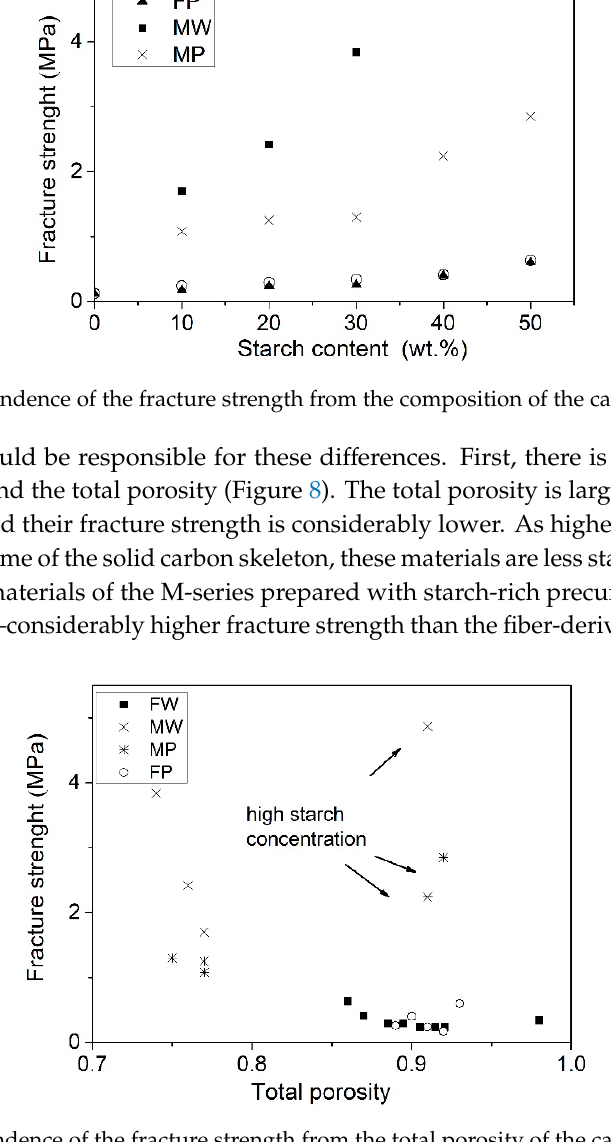
Figure 8. Dependence of the fracture strength from the total porosity of the carbon monoliths .